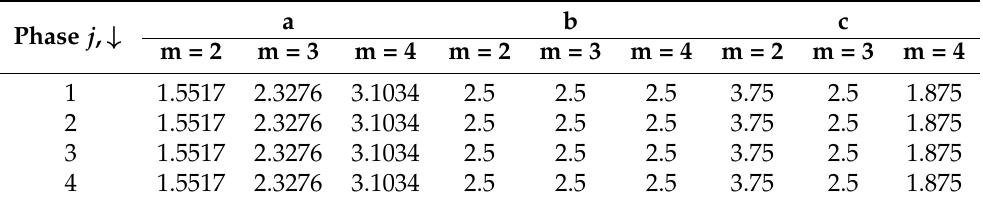
Table 9. Service Rates, µ m for various batch size, m and phase, j in Scenario II. j